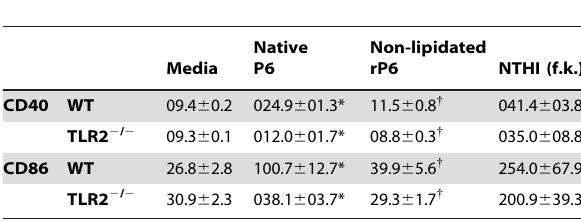
Table 1. Co-stimulatory molecule expression on BMDCs. a